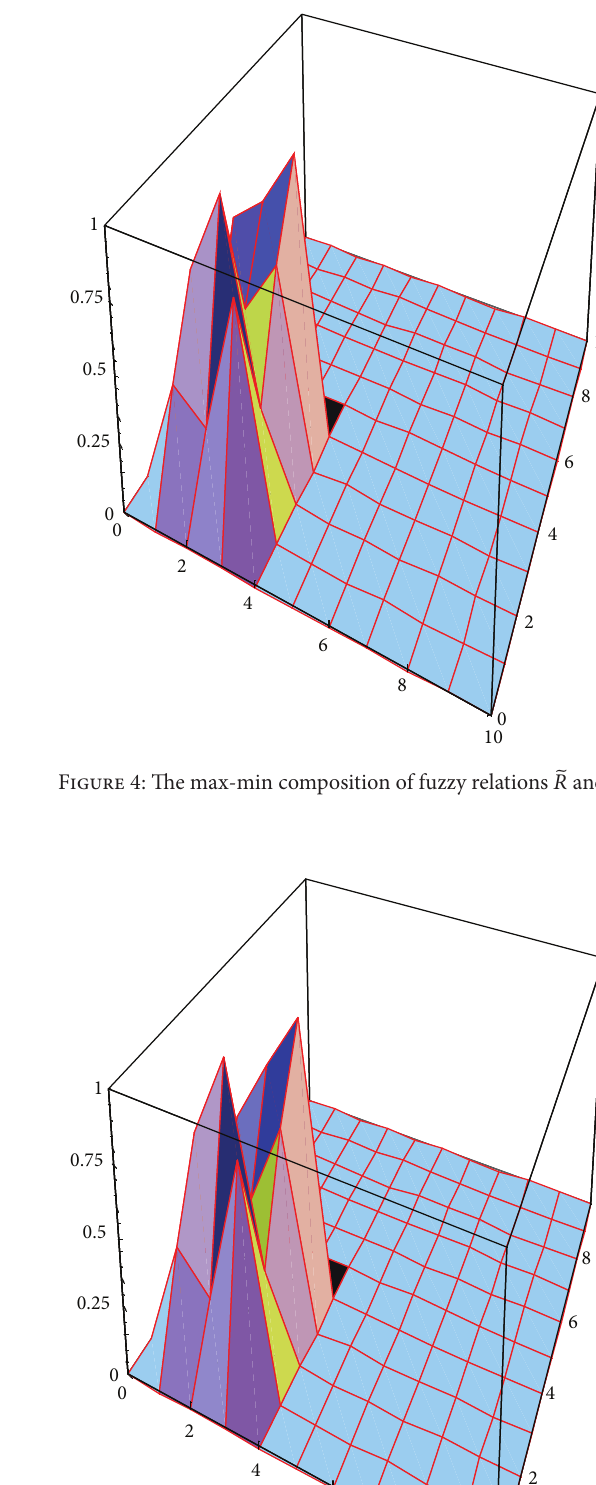
Figure 3: Fuzzy relations